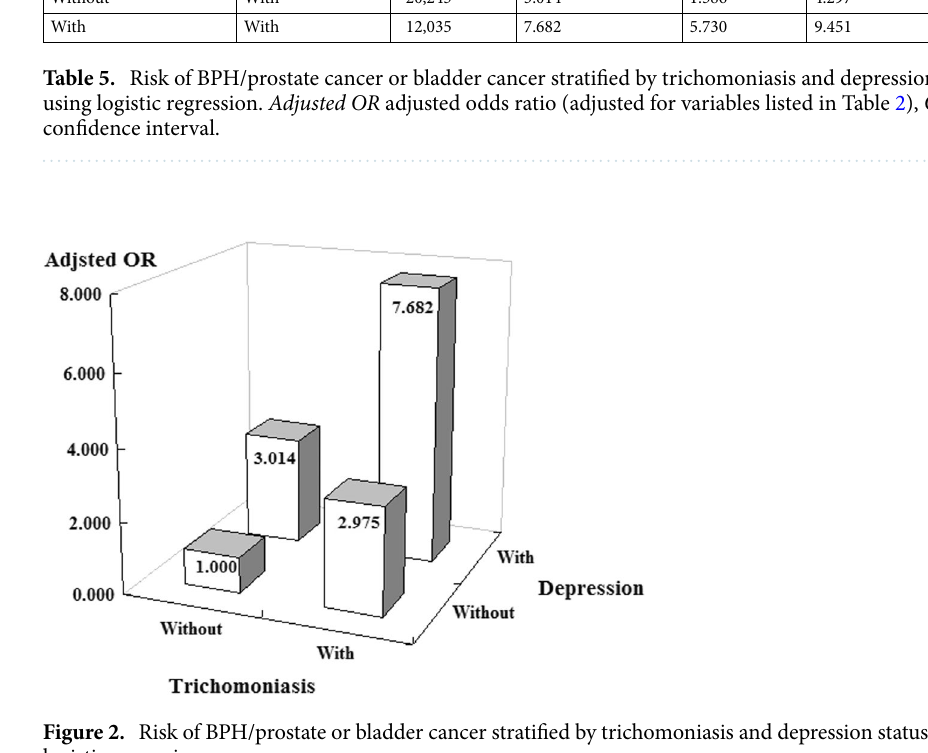
Figure 2. Risk of BPH/prostate or bladder cancer stratified by trichomoniasis and depression status using logistic